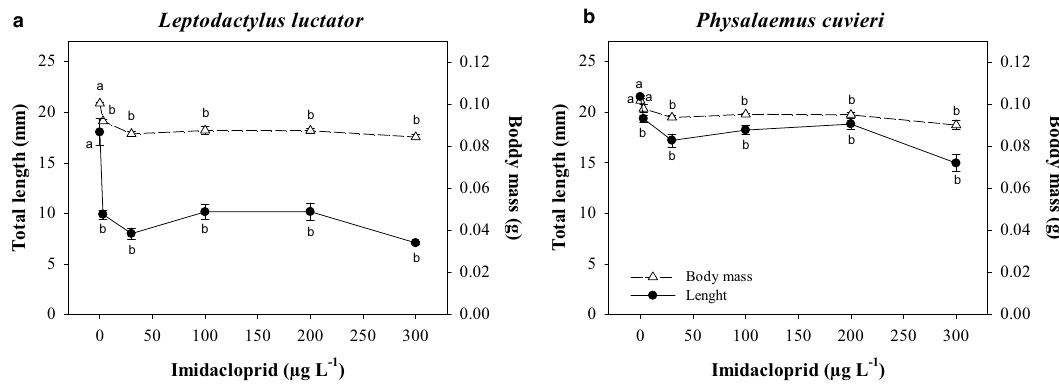
Figure 1. Total length (mm, open triangle) and body mass (g, closed circle) of the Leptodactylus luctator ( a ) and Physalaemus cuvieri ( b ) tadpoles exposed for 168 h to different concentrations of an imidacloprid-based insecticide. The data are presented as the mean ± SEM ( n =